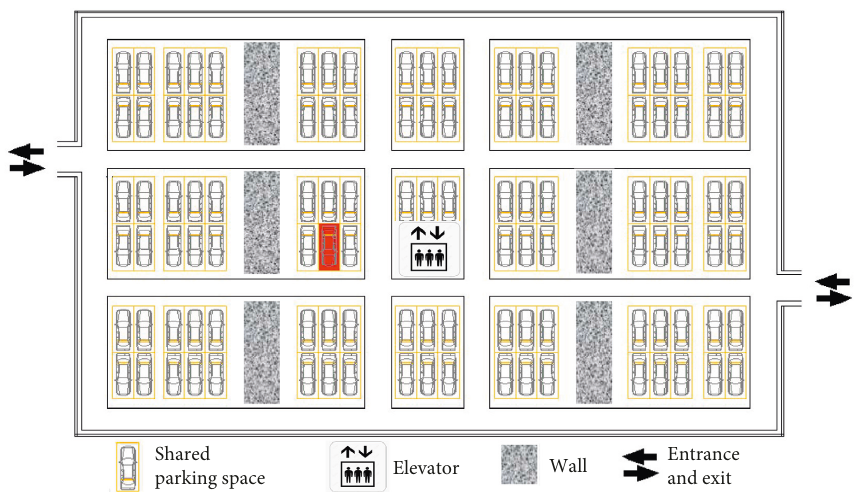
Figure 6: Layout of parking spaces and the optimal allocation of parking